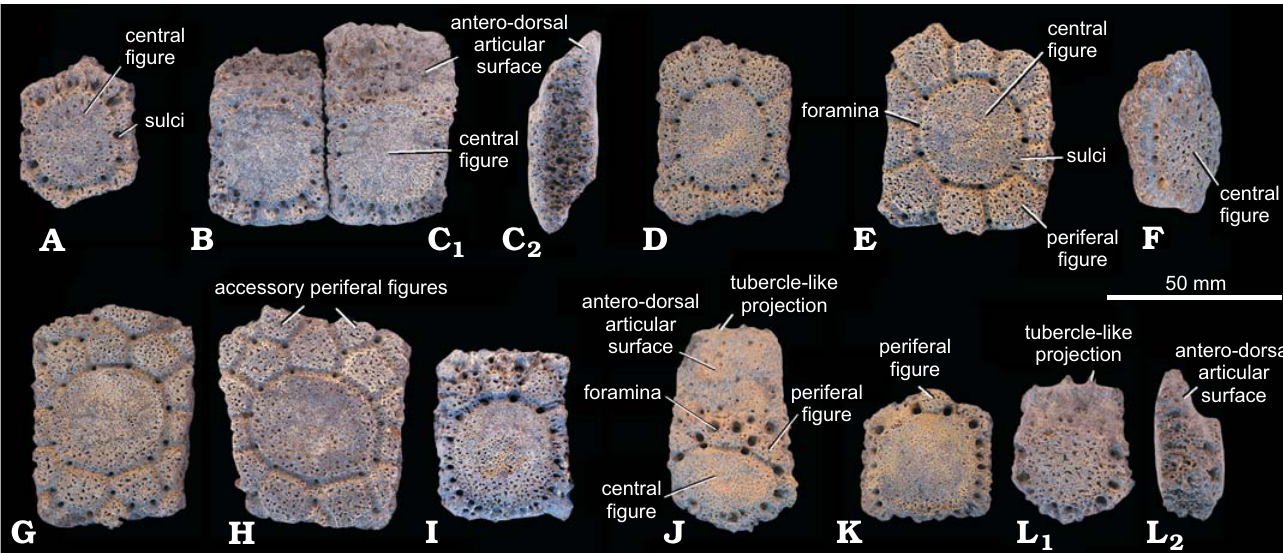
Fig. 5. Osteoderms of new specimen (MPM-PV 17410) of Palaehoplophorus meridionalis Ameghino, 1904 from Meseta de Guenguel, Patagonia, Río Mayo Formation, Serravallian–Tortonian, middle–late Miocene. Anterior region: fixed ( A ), semi-movable ( B ), movable ( C ). Middle region: fixed ( D , E ), lateral margin ( F ). Posterior region: fixed ( G , H ), posterior margin ( I ). Caudal rings: movable ( J ), fixed ( K ). Indeterminated region: semi-movable ( L ). Osteoderms in lateral view (C 2 , L 2